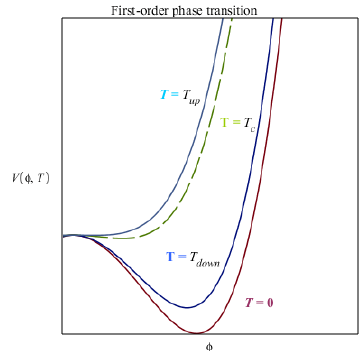
Figure 2 . Old in(cid:13)ation as a (cid:12)rst order phase transition is in term of tunneling between false vacuum (local minimum at (cid:30) = 0) and true vacuum (global minimum at (cid:30) > 0). In this (cid:12)gure we can compare the symmetric phase with T > T c and broken phase with T < T c